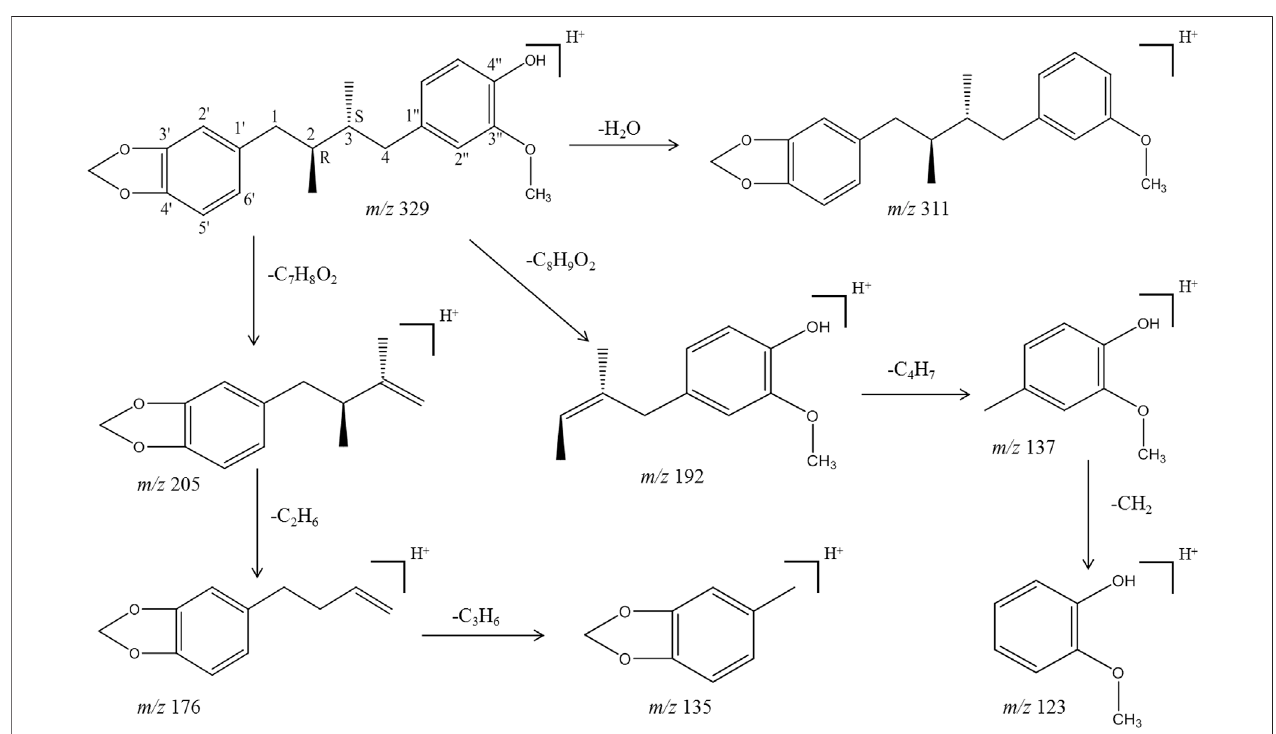
FIGURE 7 | Proposed mainly MS/MS fragmentation pathways for anwulignan.